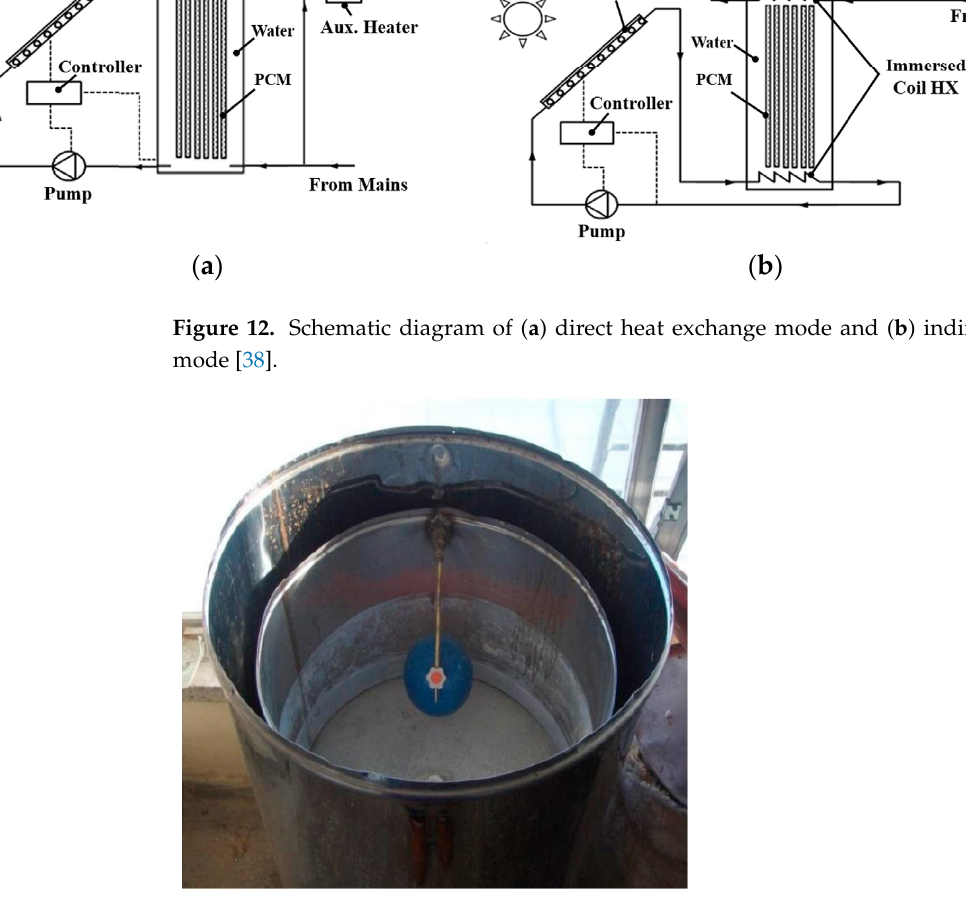
Figure 13. The LHTES studied by K ı l ı çkap et al. [39].